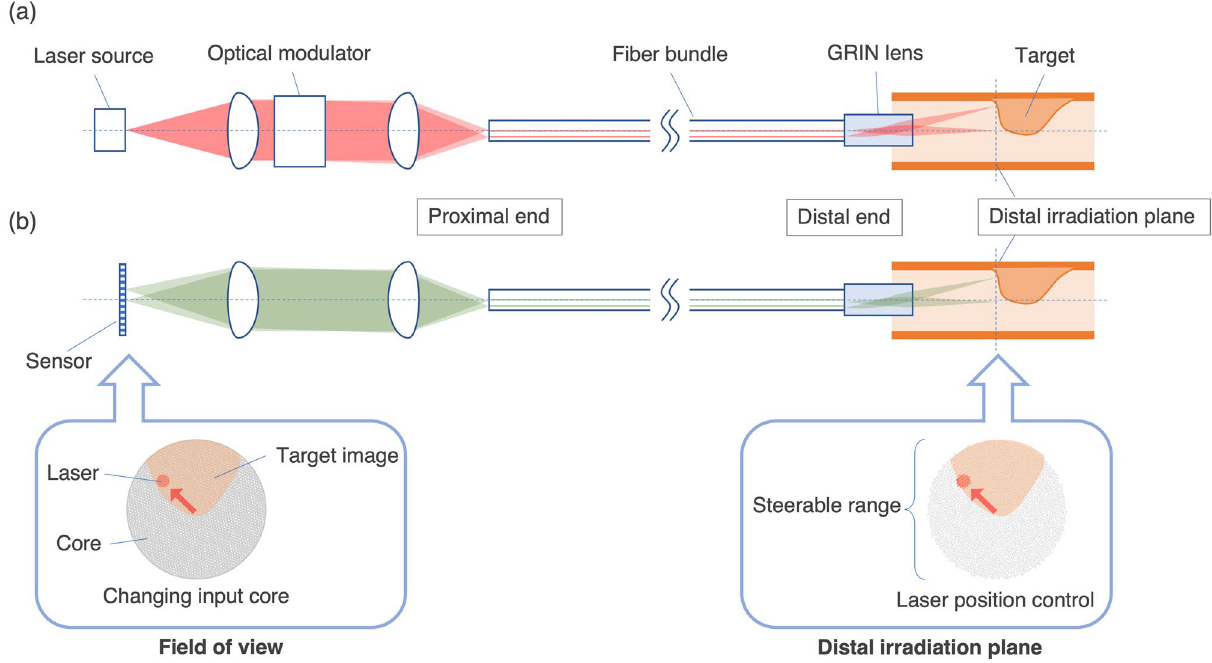
Figure 1. Schematic illustration of our endoscopic image-guided laser treatment system using a fiber bundle for ( a ) laser steering and ( b ) endoscopic imaging. The figure was generated by the authors with Microsoft Power Point for Mac (v. 16.69.1) 35